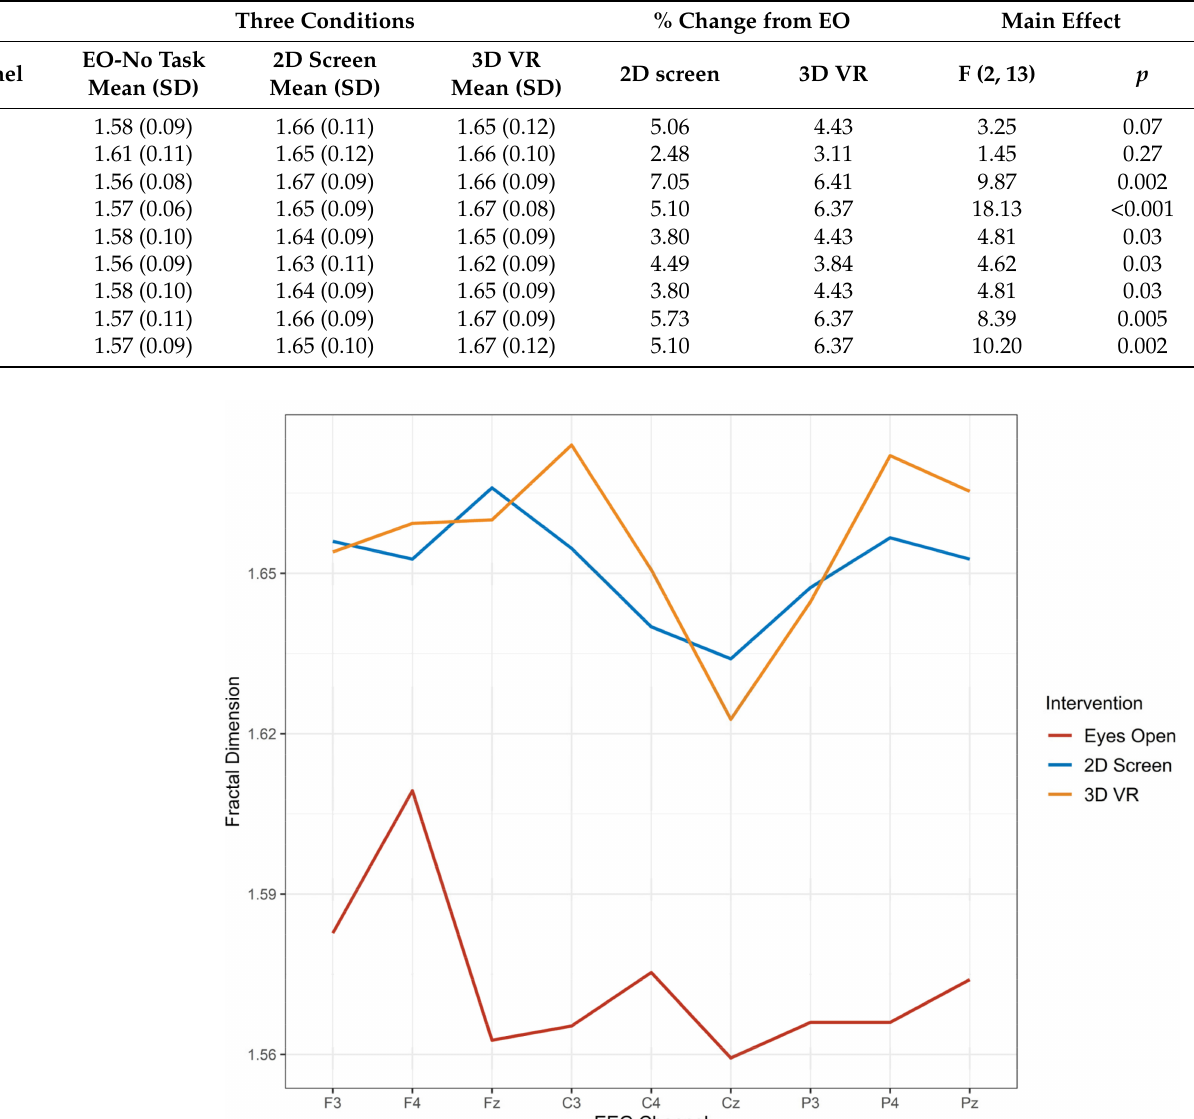
Table 7. Fractal dimensions in nine EEG sites for the three conditions EO-no task, 2D screen and